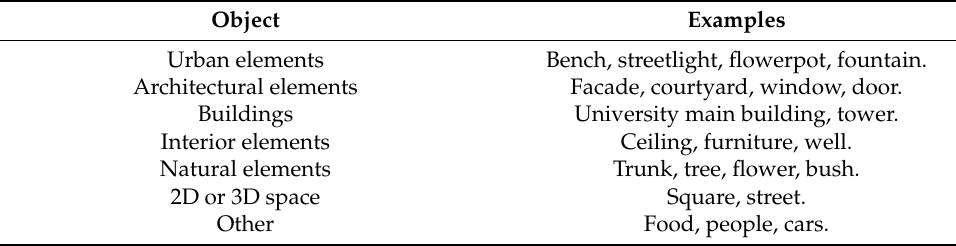
Table 1. Object or element type in Math Trails